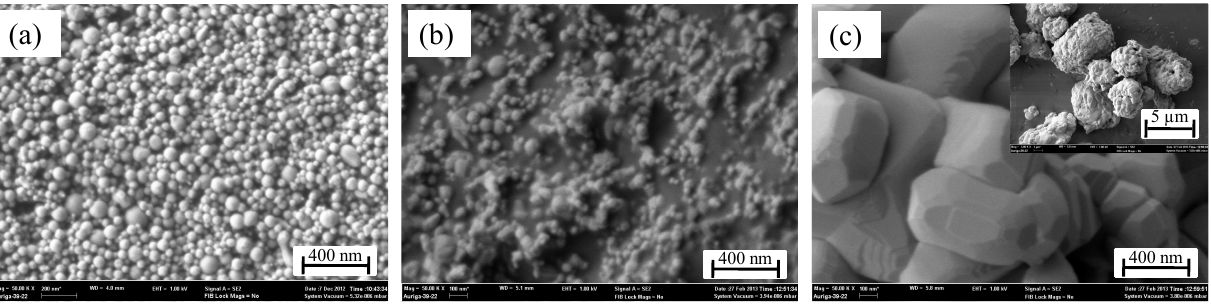
Figure 2. TEM images of the TiO